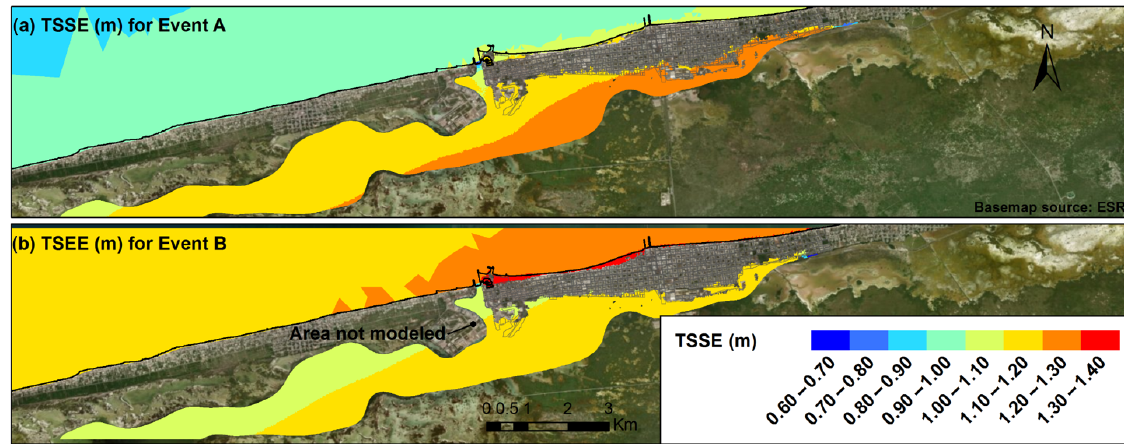
Figure 10. Maximum flooding over Progreso during (a) Event A and (b) Event B.